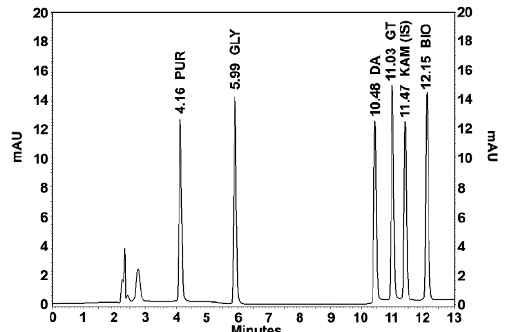
Figure 3. Chromatogram obtained from a mixed standard containing isoflavones: PUR, GLY, DA, GT, BIO and KAM (IS) using the HPLC-DAD